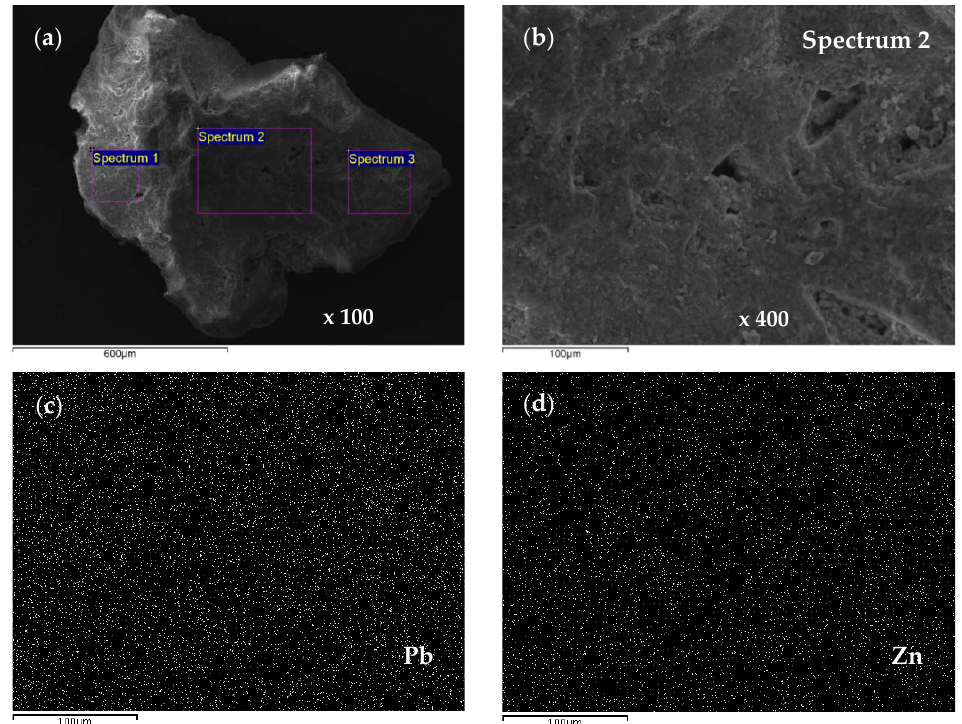
Figure 18. ( a ) An SEM image of a zeolite grain with three spectrums for the (Pb + Zn) system and Pb/Zn = 1.07; ( b ) spectrum 2 with a magnification of 400; ( c , d ) a mapping analysis across the spectrum 2 surface with a mean wt.(%) of 20.06 Pb and 0.76 Zn.